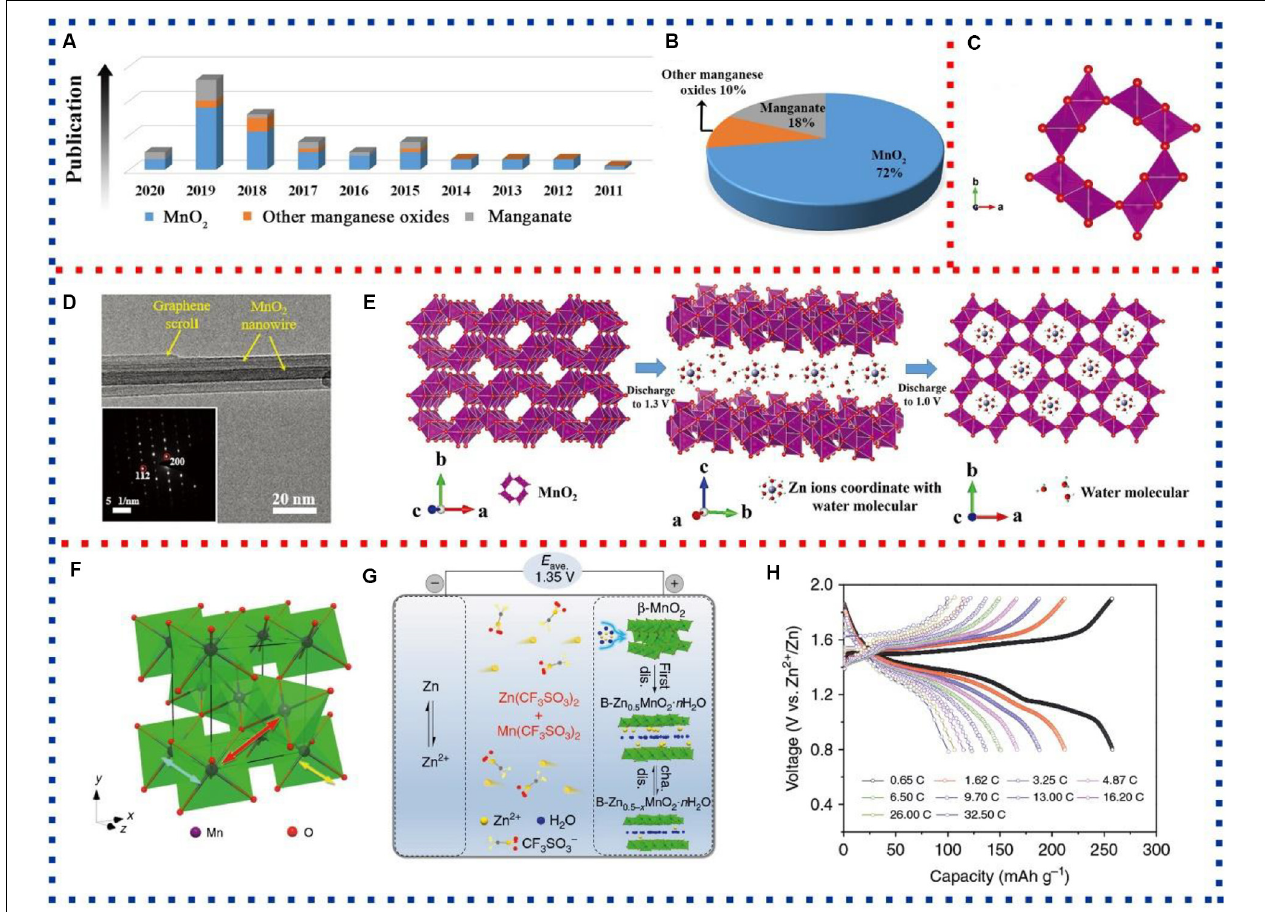
FIGURE 1 | (A) The statistical table of manganese-based materials reported in aqueous rechargeable zinc-ion batteries (AZIBs). (B) The percentage of different manganese-based materials reported in AZIBs. (C) Schematic diagram of α -MnO 2 crystal structure. (D) Transmission electron microscopy (TEM) and corresponding selected area electron diffraction (SAED) of α -MnO 2 /graphene scrolls (MGS). (E) Schematic diagram of zinc ions inserting into the MGS electrode in two steps. (F) Schematic diagram of β -MnO 2 crystal structure. (G) Schematic diagram of the Zn/ β -MnO 2 batteries with β -MnO 2 as cathode, Zn(CF 3 SO 3 ) 2 add Mn(CF 3 SO 3 ) 2 as electrolyte. (H) Discharge/charge profiles of Zn/ β -MnO 2 batteries. (C) Reprinted with permission (Gao X. et al., 2020). Copyright 2020, WILEY-VCH. (D,E) Reprinted with permission (Wu et al., 2018). Copyright 2018, WILEY-VCH. (F–H) Reprinted with permission (Zhang et al., 2017). Copyright 2017, Springer